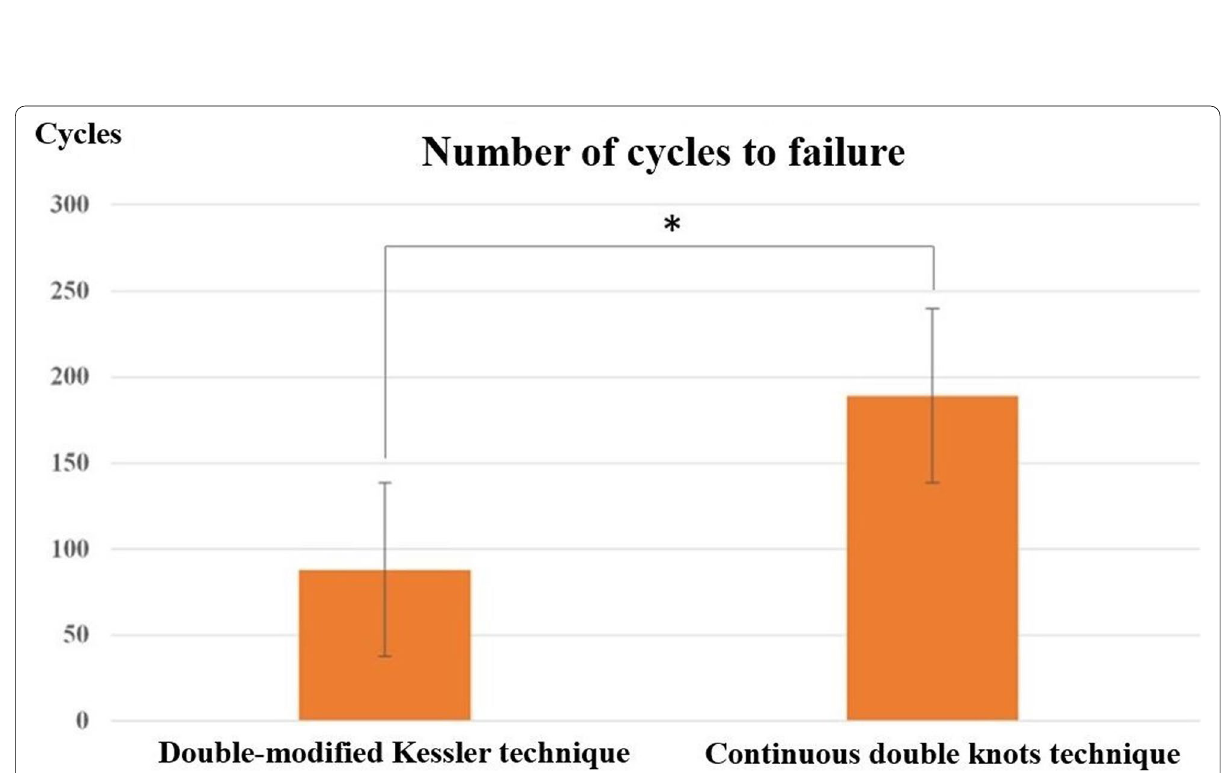
Fig. 6 Comparison of number of cycles to failure shown for each tendon repair technique. The difference between the double-modified Kessler technique and the continuous double knots technique was statistically